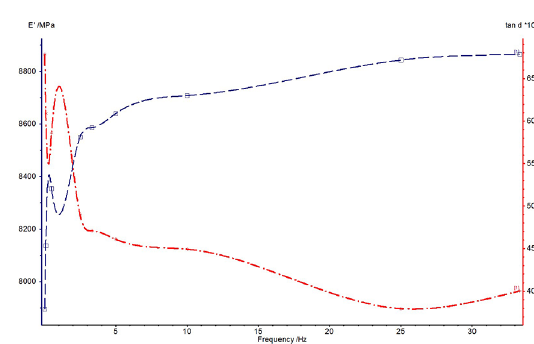
Figure 6. Young’s Modulus and Tangent Delta dependence on frequency for Cedrela sp .